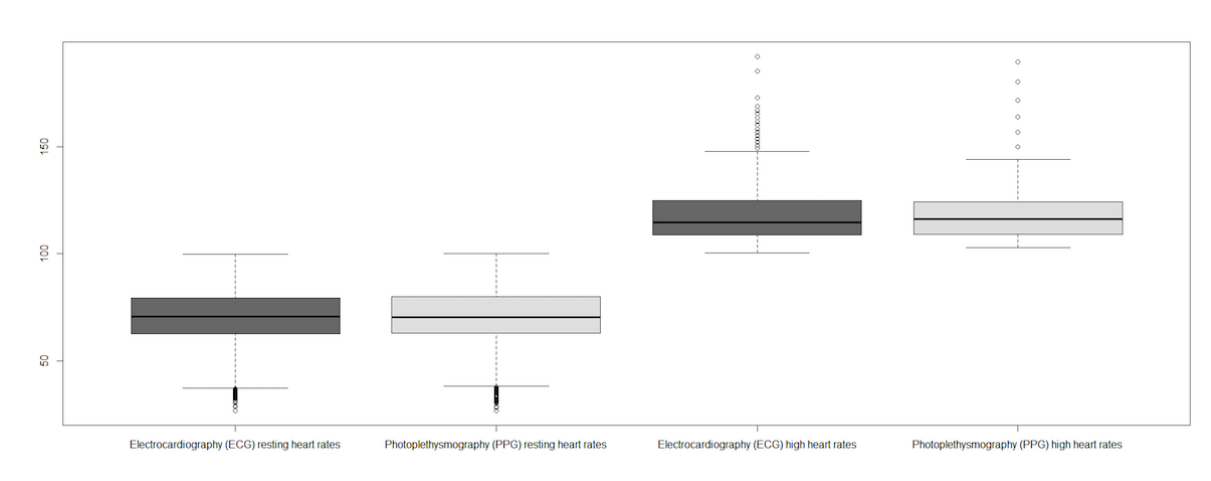
Figure 10. Overview heart rates divided in resting and high heart rates.